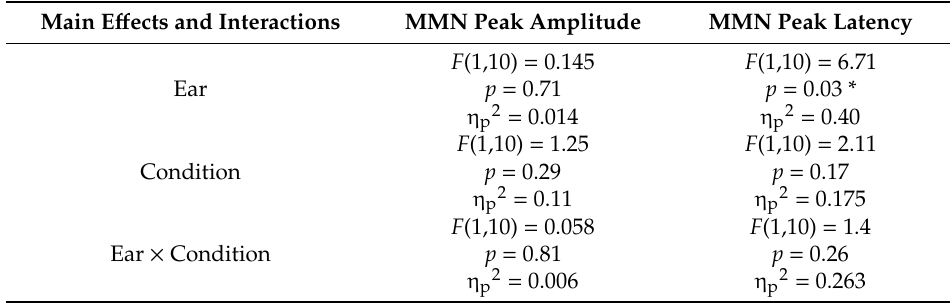
Table 5. Descriptive statistics of peak amplitudes and peak latencies of MMN and P300 in the two conditions in the two ears. Please see text for sites grouped for analysis. CAS = Contralateral Acoustic Stimulation, µV = micro Volts, ms = milliseconds, SD = Standard Deviation. Table 4. Repeated-measures ANOVA results for MMN amplitude and latency. (* stands for p < 0.05). Main E ff ects and